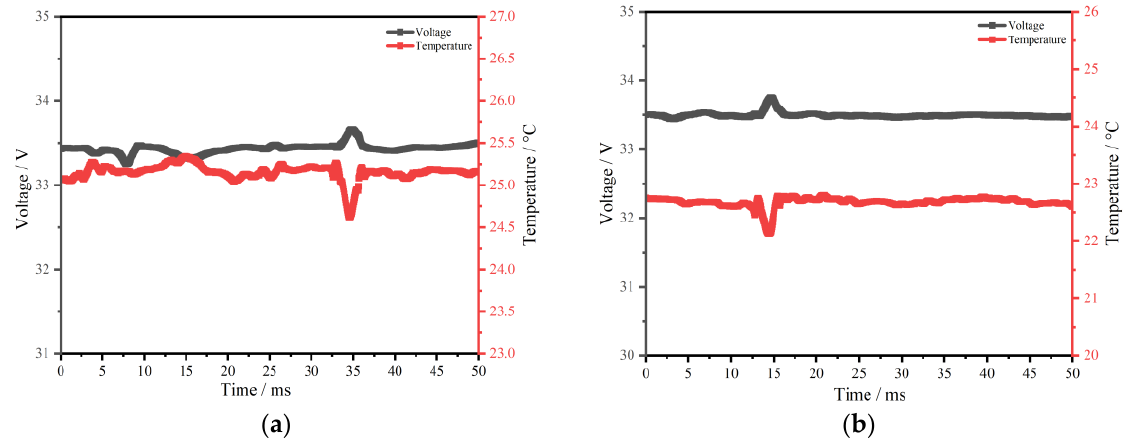
Figure 11. Voltage – temperature – time curve of the battery module in both Z+ orientations. ( a ) Z1+ Figure 11. Voltage–temperature–time curve of the battery module in both Z+ orientations. ( a ) Z1+ orientation test results; ( b ) Z2+ orientation test results. orientation test results; ( b ) Z2+ orientation test results.